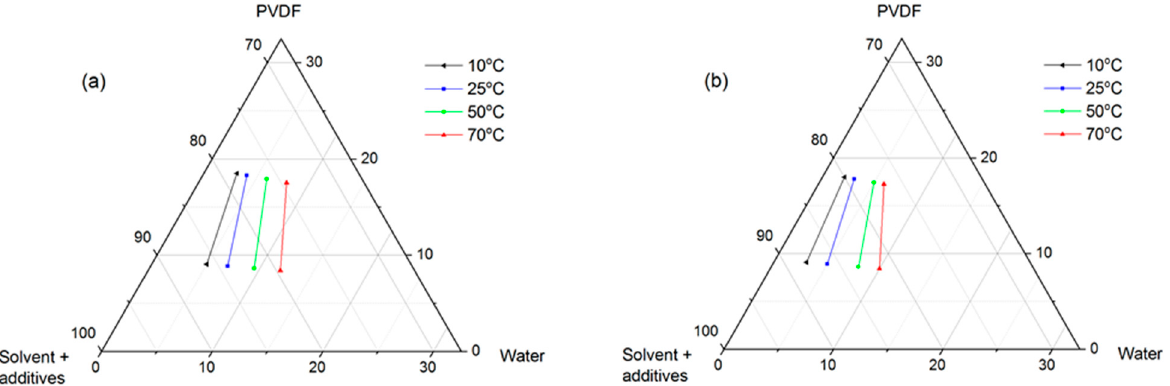
Figure 1. Phase diagram of ( a ) PVDF/DMAc,PEG/H 2 O and ( b ) PVDF/DMAc,PEG, TiO 2 /H 2 O systems.